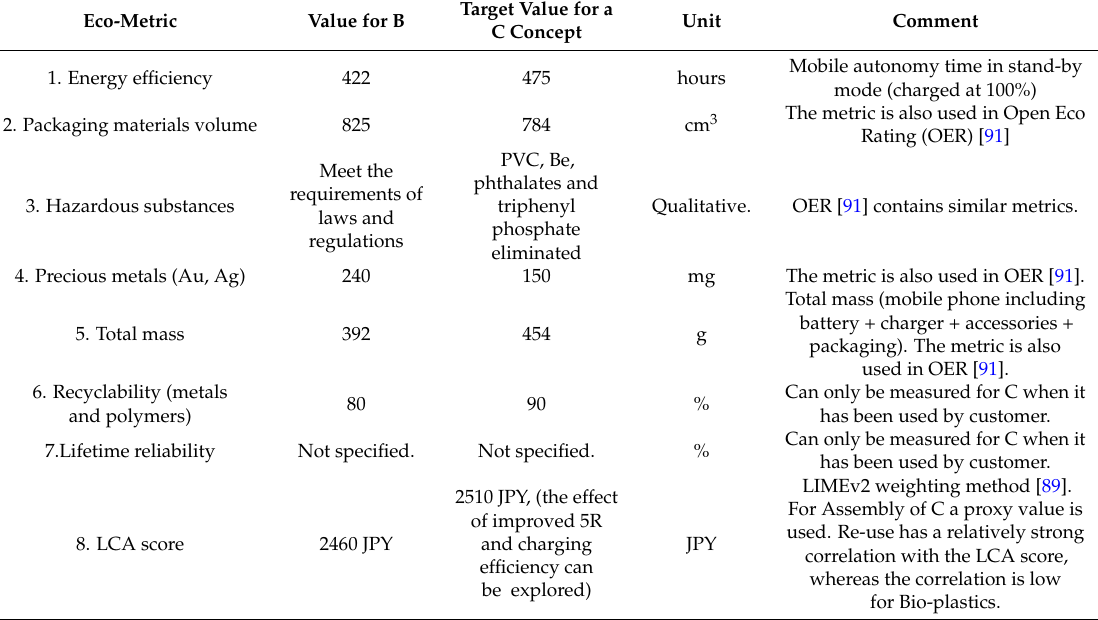
Table 1. Eco-metric values for B and a concept of C in Design Step